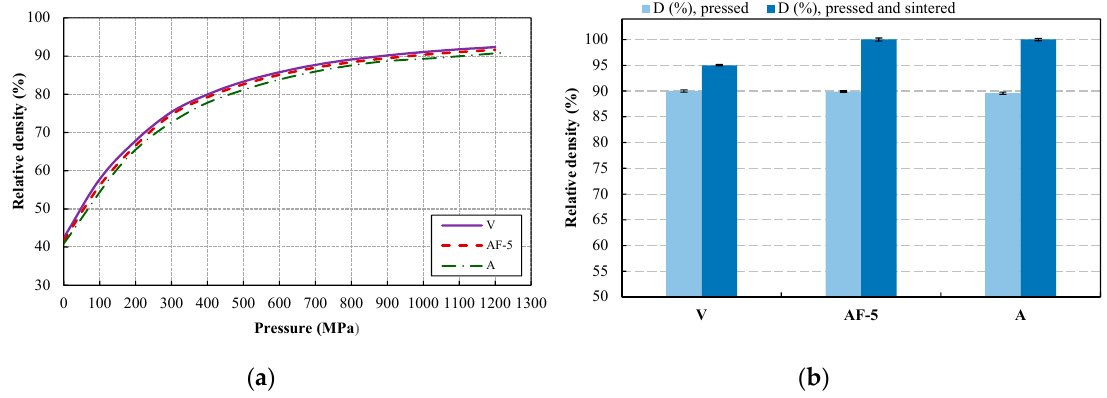
Figure 3. ( a ) Compressibility curves of mechanically alloyed aluminium powders and ( b ) relative density after being pressed and sintered.